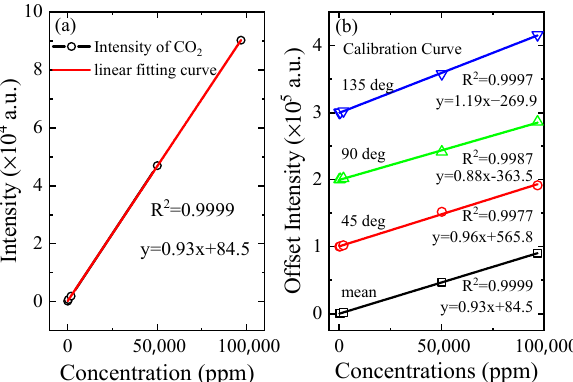
Figure 5. ( a ) The calibration curve of the mean spectrum. ( b ) The comparison of four calibration curves; three of them are the spectra at different collection angles and the bottom one (in black) is the mean values of these three spectra.